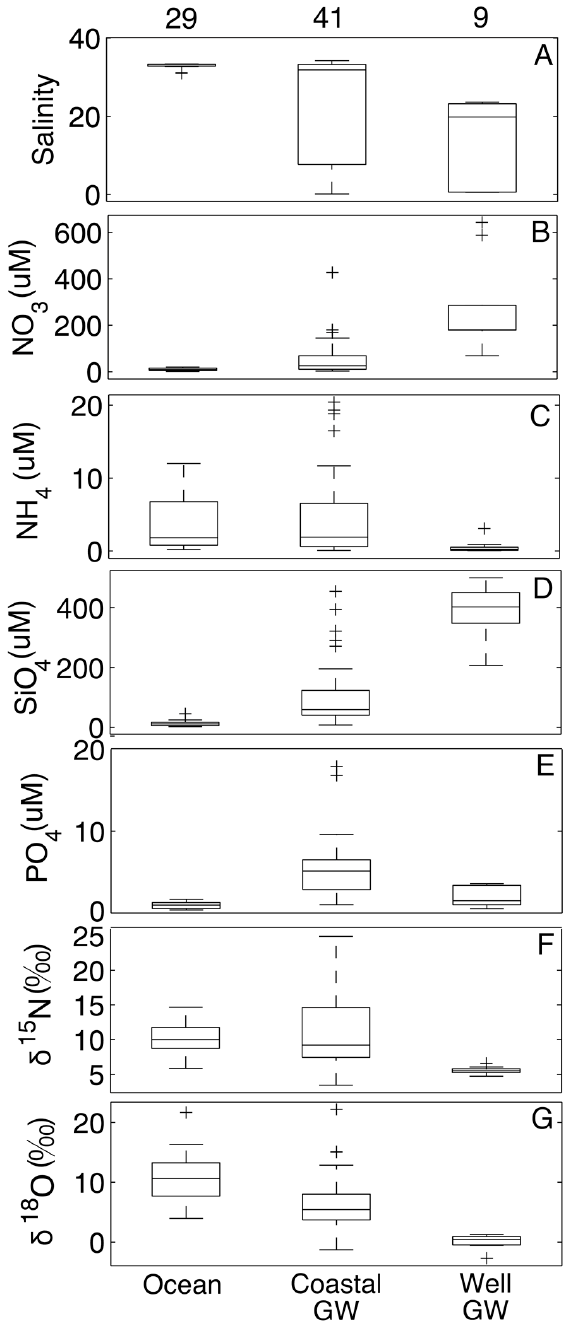
Figure 2. Box plots of salinity ( A ), nitrate ( B ), ammonium ( C ), silicate ( D ), and phosphate ( E ) concentrations, and δ 15 N NO3 ( F ) and δ 18 O NO3 ( G ) data from monitoring wells (Well GW), groundwater from the beach face (Coastal GW), or Monterey Bay itself (Ocean). Numbers at the top indicate the number of samples per group. Silicate concentrations and δ 18 O NO3 were statistically different between all three water types (Tukey-Kramer, p < 0.05).